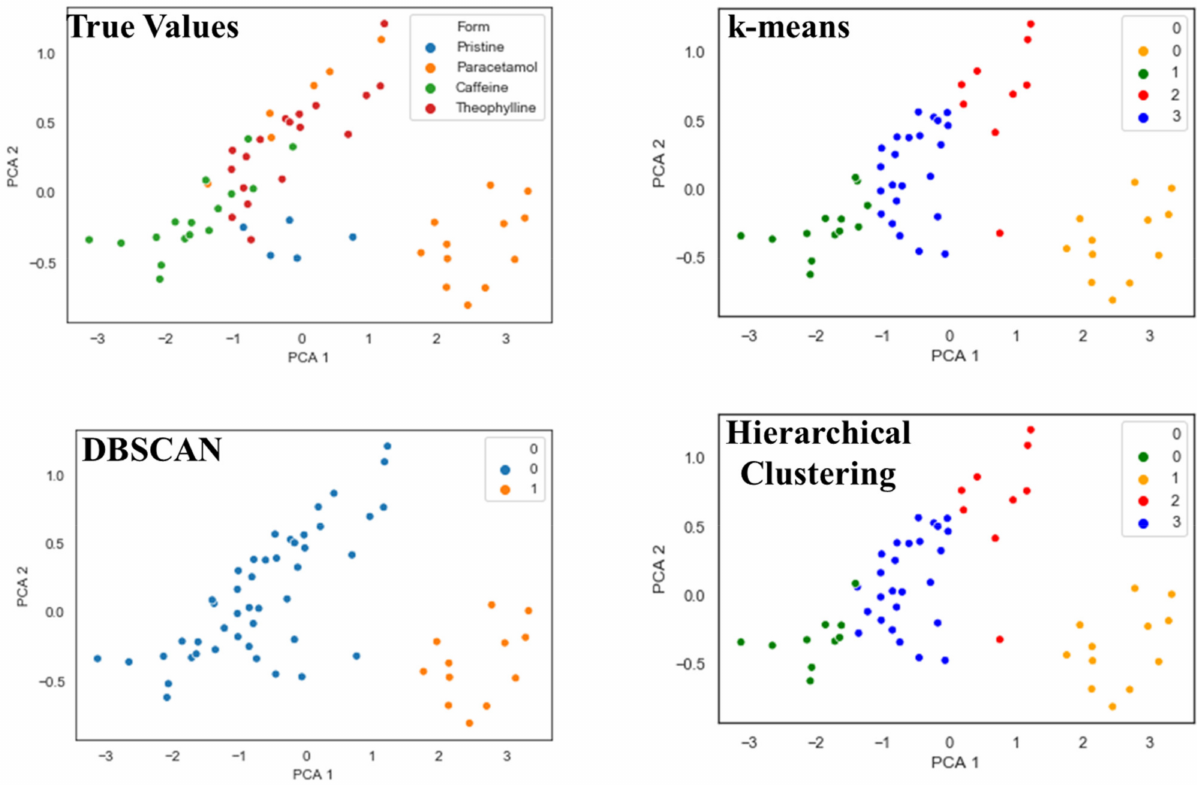
Figure 8. Two component PCA of the raw NIR spectra. PCA resulted in overlaps between clusters, which k-means, DBSCAN and hierarchical clustering were unable to exactly replicate. k-means and hierarchical clustering inherently identified four different clusters (clusters 0,1,2, and 3); however, they were not an exact match to the true values. DBSCAN was only able to